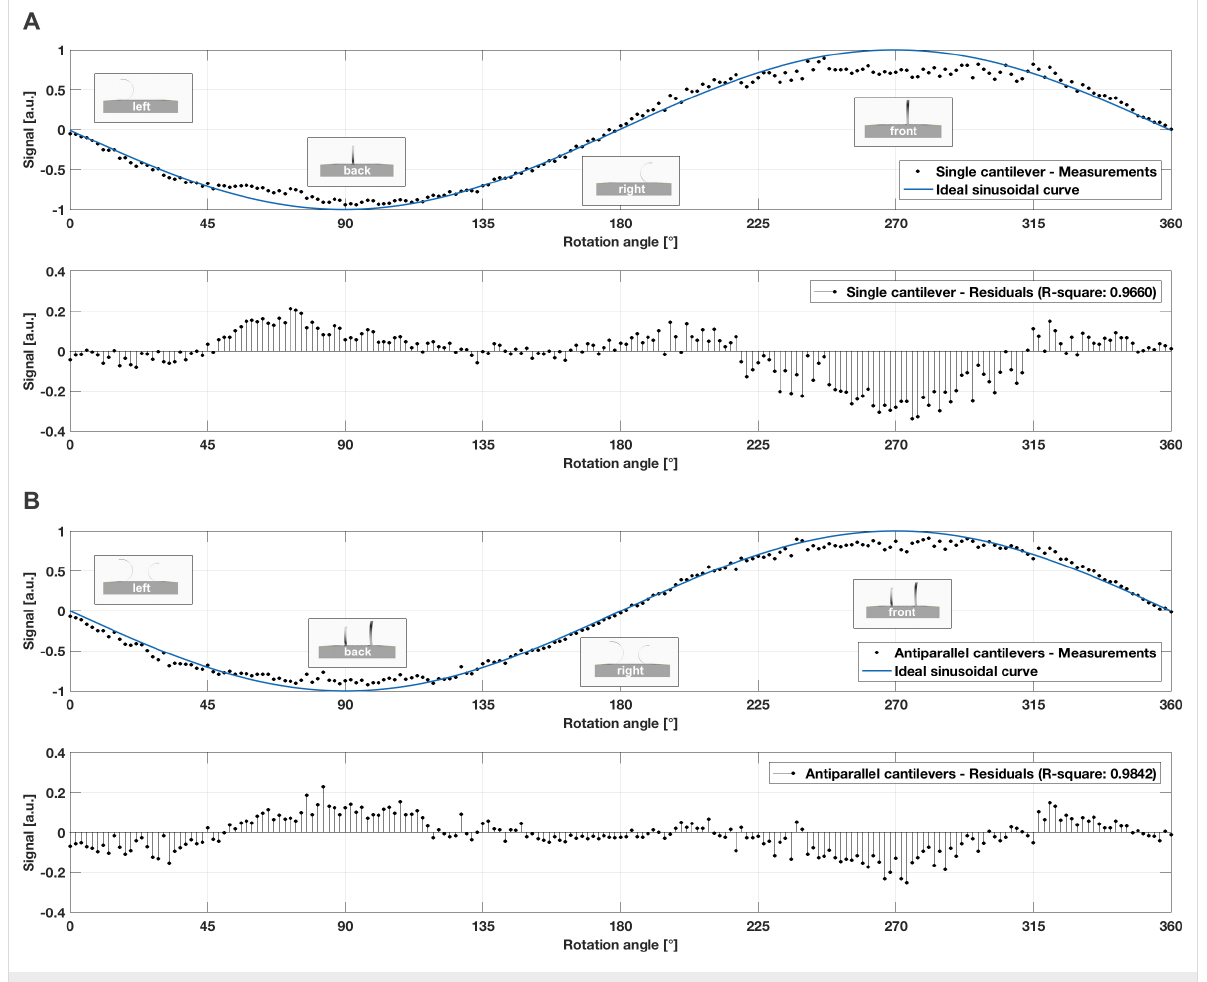
Figure 9: Response behaviour of the (A) single and (B) antiparallel artificial hair sensor to multidirectional air flow. The first (upper) plots compare the measured output voltage of the Wheatstone bridge (black dots) with the expected ideal sinusoidal curve (blue curve), whereas the second (lower) plots present the residuals of the ideal signal. Data (average mean of 30,000 measurement values) is shown as a function of rotation angle. Signal amplitude was normalized.